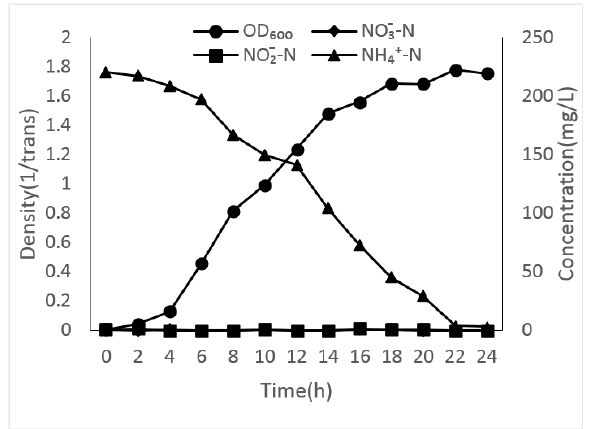
Figure 2. Growth curve of synthetic microbial community with NH 4 Cl as the sole nitrogen source.